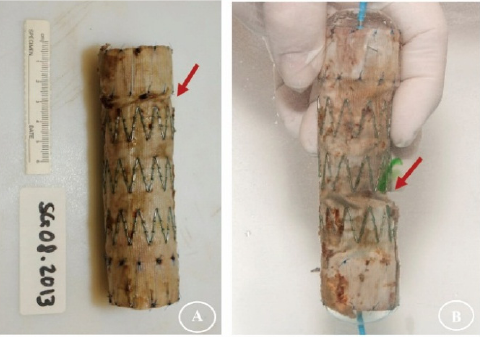
Figure 1. Twisting in explanted Talent stent ‐ grafts. The area of the crotch of the bifurcation holds an irregular encapsulation, likely to prevent blood endoleak ( A ). The twisting can, however, be more evidenced ( B : arrows) and results in fluid percolation ( C : arrows).